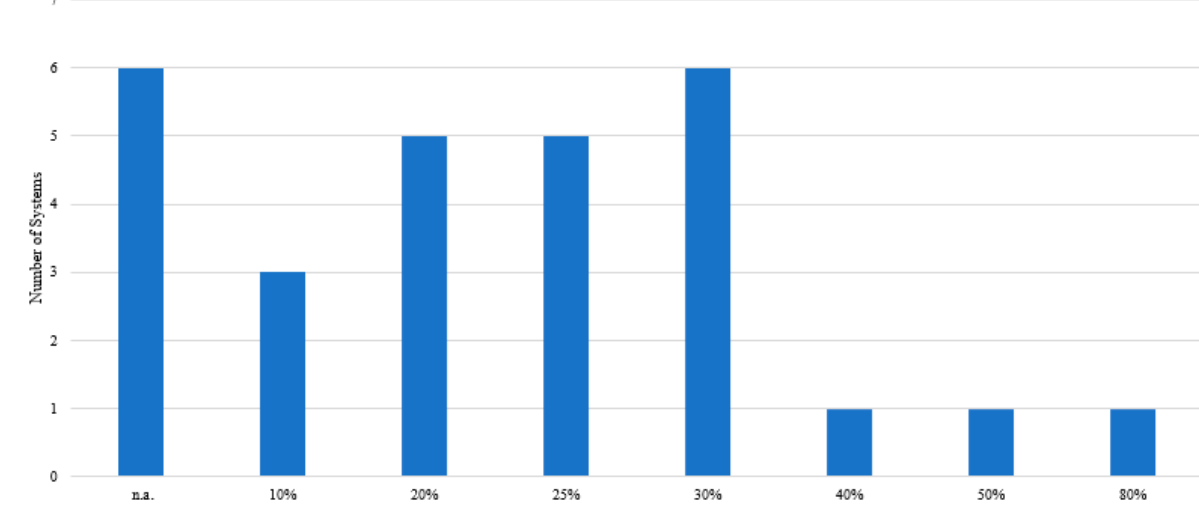
Figure 5. Amount of water used to aid extraction of phenolic compounds from different natural matrices, with n.a. Meaning information not available or that water was not added.